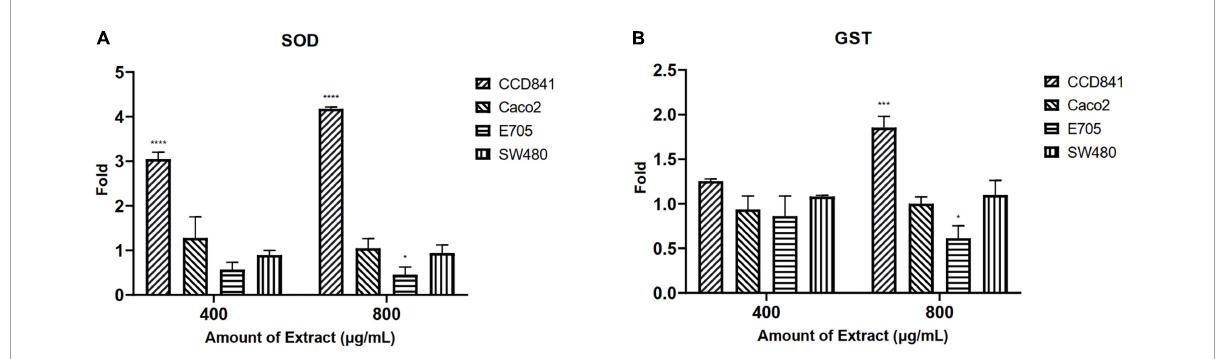
FIGURE5 Fold increase in (A) superoxide dismutase (SOD) and (B) glutathione S-transferase (GST) activity after 48 h of treatment. The statistical analysis used a linear model against a fold control equal to 1 (* p < 0.05, *** p < 0.001, and **** p < 0.0001).